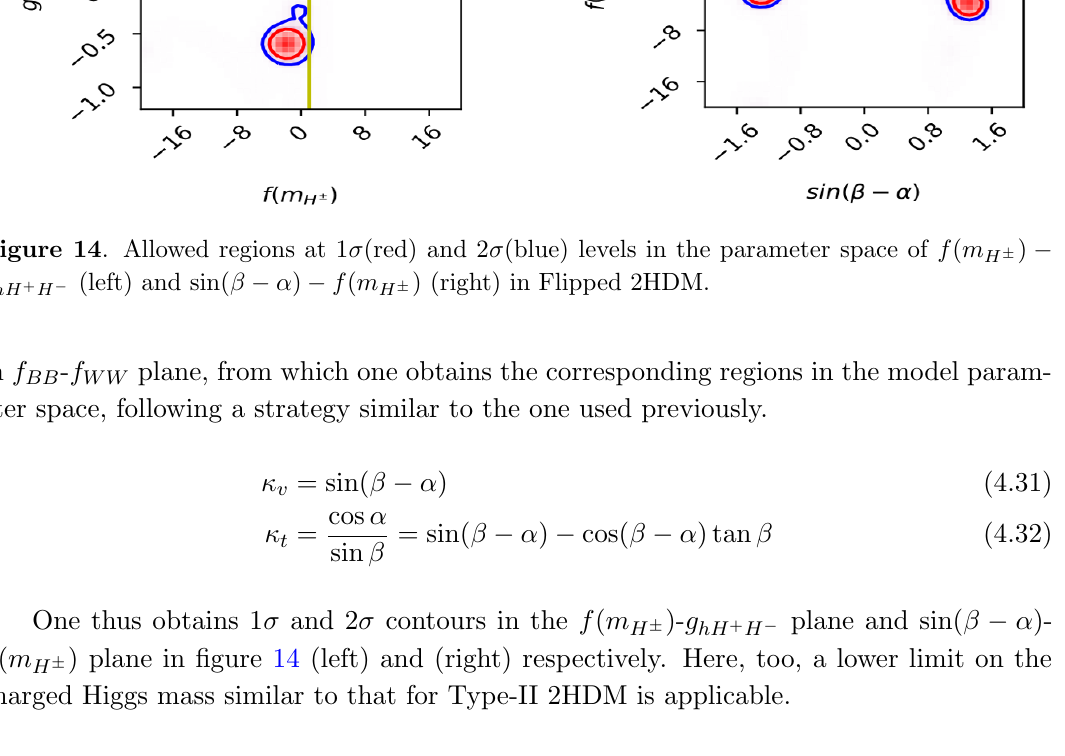
) (right) in Flipped H (cid:6)